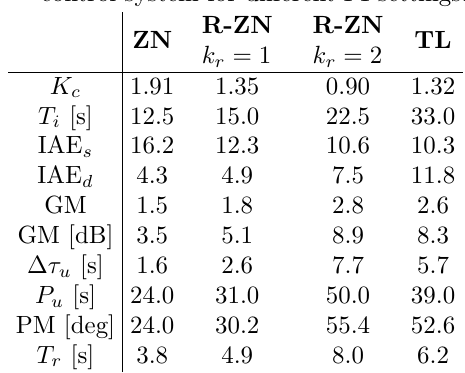
Table 4: Controller settings and performance and ro- bustness measures for practical temperature control system for different PI settings.